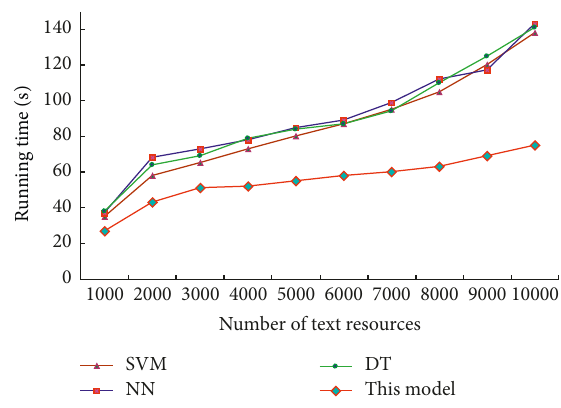
Figure 8: Efficiency comparison of real-time classification of ed- ucational information resources provided by cloud service centers with different